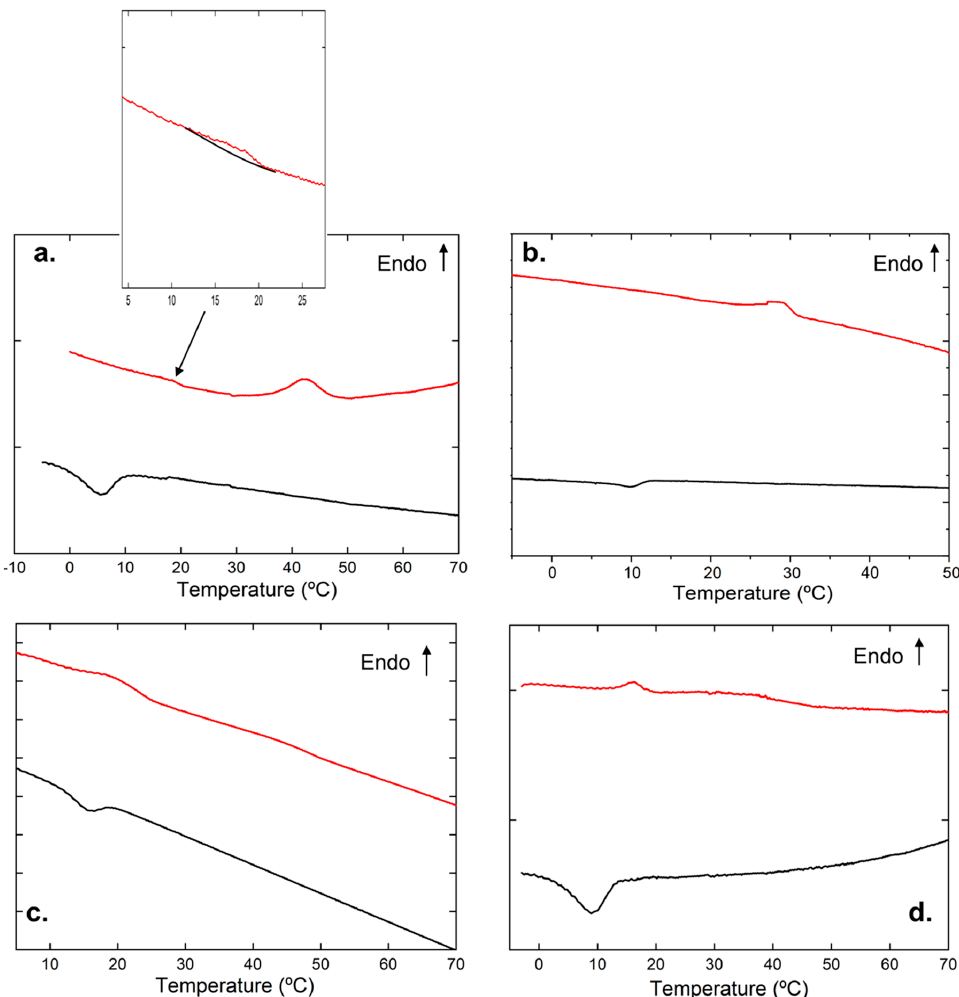
Figure 1. Representative di ff erential scanning calorimetry curves obtained on cooling (red) and on heating (black) for: ( a ) Pure iPS gel in cis-decaline (4%, g / mL) (inset: Amplification of the first endothermic peak at 18 ◦ C), ( b ) metallo-organic polymer gel in cis-decaline (0.9%, g / mL), ( c ) hybrid gel iPS / metallo-organic polymer (iPS = 4%, g / mL and metallo-organic polymer = 5.1%, g / mL), and ( d ) hybrid gel iPS / metallo-organic polymer (metallo-organic polymer = 1.4%, g / mL and iPS = 5.4%, g /